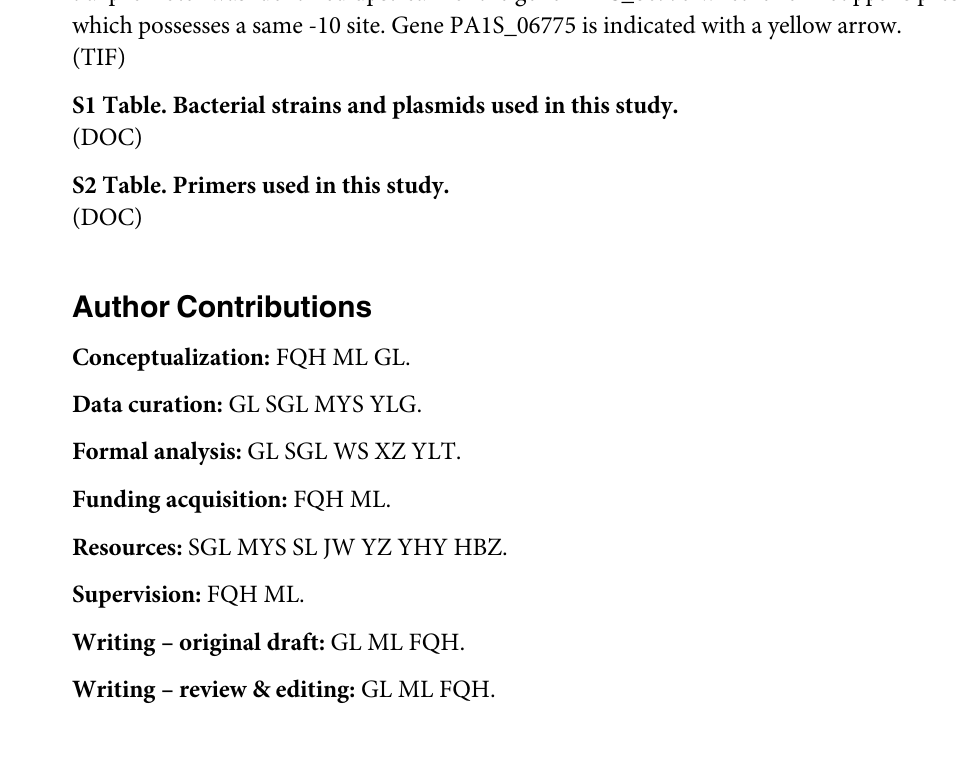
S1 Fig. Validation of DNase protection assay for phage particle detection. The PA1 lysate induced by lytic phage PaP1 was filtered and serially diluted. Aliquots of dilutions 10 0 , 10 − 4 , and 10 − 7 were used in the DNase protection assay. The primer pair used here is ORF48-F/ ORF48-R. Phage PaP1 particles could be detected in PA1 lysates even at 10,000-fold dilution. S2 Fig. Quantitation of pp3 excision frequency. (A) Primers used for quantitative PCR. (B) To measure the frequency of pp3 excision, standard curves were generated using primer pairs tot-F/tot-R and pro-F/pro-R. S3 Fig. Prediction of promoters upstream of the gene PA1S_06775 upon pp3 integration and excision. Prophage pp3 excision does not affect the amino acid sequence of PA1S_06775, although there is a transition from T to C in the nucleotide sequence (marked in red). A poten- tial promoter was identified upstream of the gene PA1S_06775 whether or not pp3 is present, which possesses a same -10 site. Gene PA1S_06775 is indicated with a yellow arrow. S1 Table. Bacterial strains and plasmids used in this study. S2 Table. Primers used in this